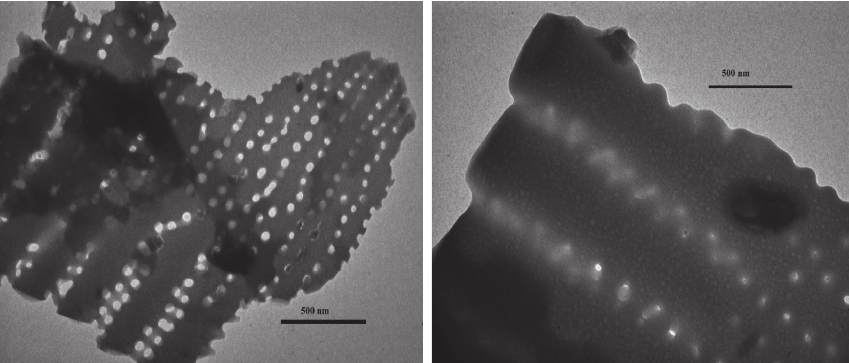
Figure 5: TEM image of the 2CuCl/diatomite